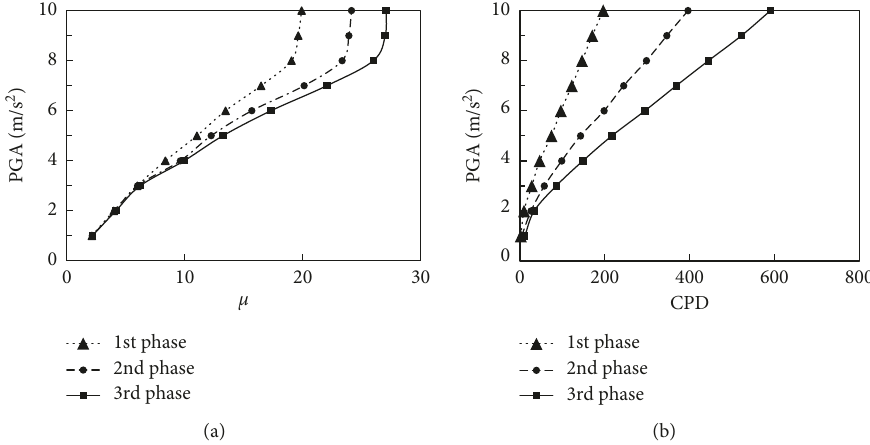
Figure 7: Comparison of the three seismic response of a BRB: (a) PGA-ductility; (b) PGA-CPD.